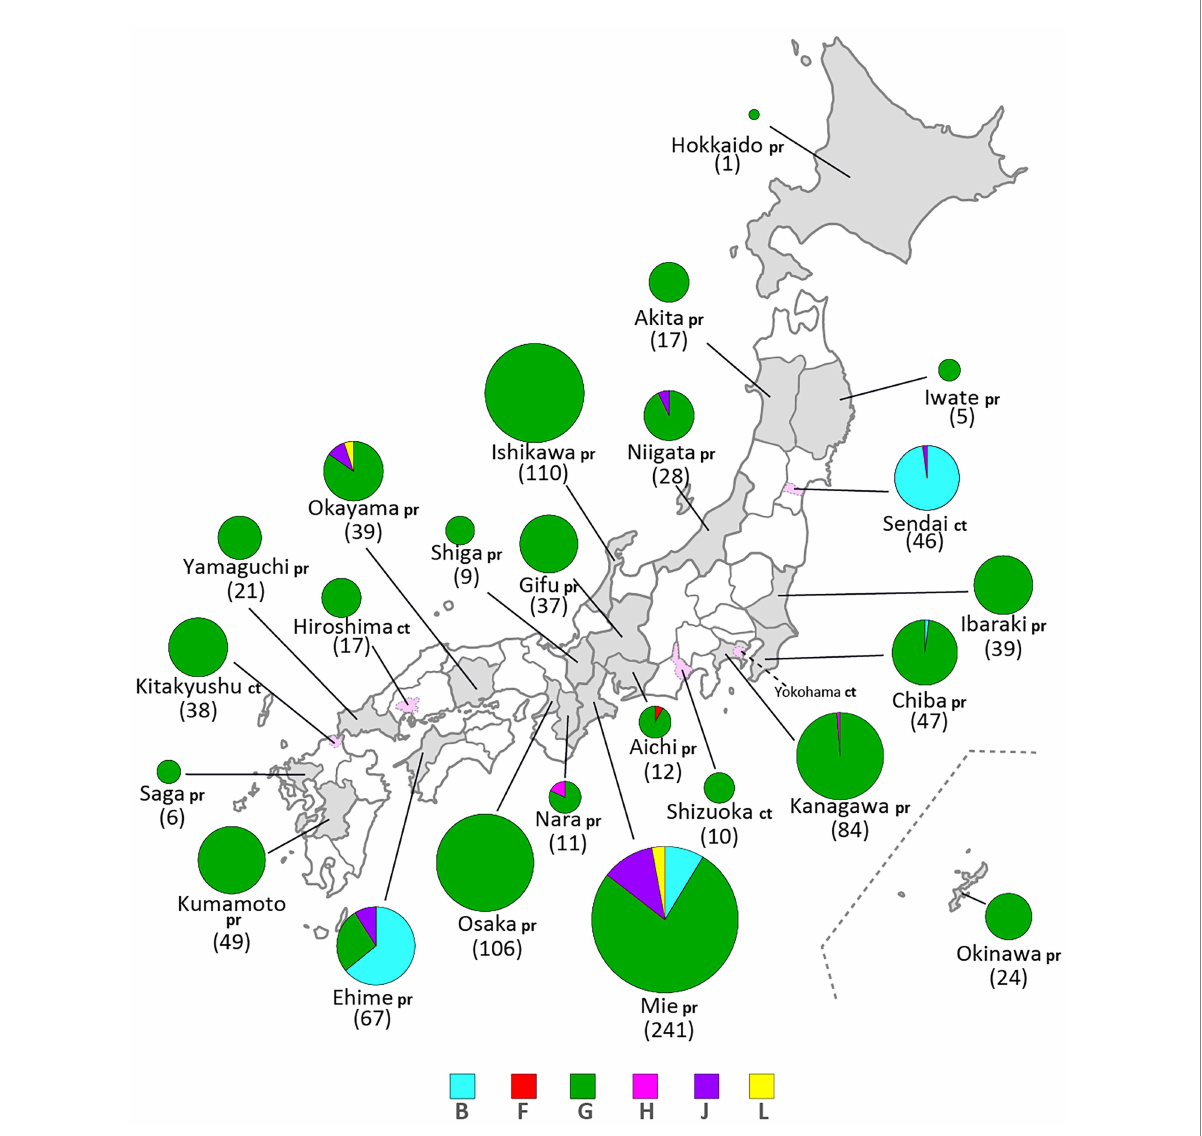
FIGURE 4 Geographical distributions of mumps virus (MuV) genotypes identified in this study from 1986 to 2017. Identified genotypes are differentiated by color. The numbers in brackets refer to the total numbers of the MuVs isolated from the prefectures (pr) or cities (ct). The administrative divisions where MuVs were isolated are color coded: grey-colored area for prefecture, pink-colored area surrounded by dashed line for